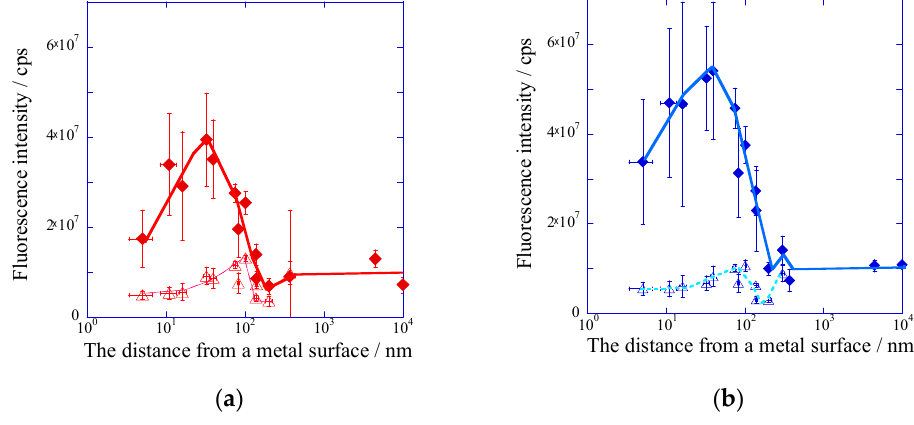
Figure 4. Fluorescence peak (solid line and rhombuses) and base (broken line and triangles) intensities plotted against the distance from a metal surface ( a ) in DAS system and ( b ) in IAS system.